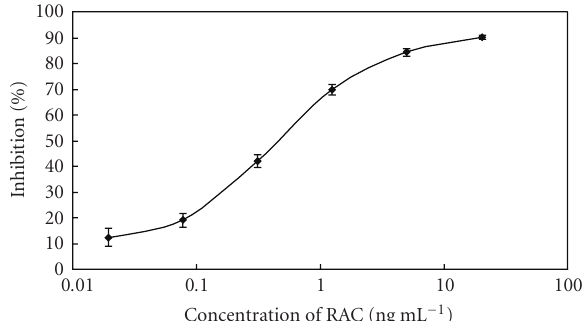
Figure 2: Optimization of ionic strength of the diluting bu ff er ( n = 3).